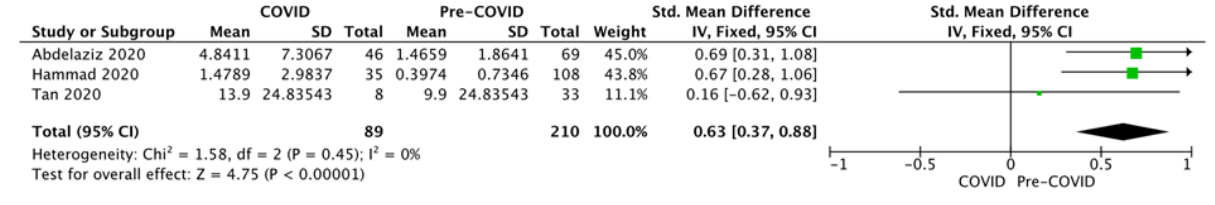
Figure 6. Forest plots for troponin-I level.